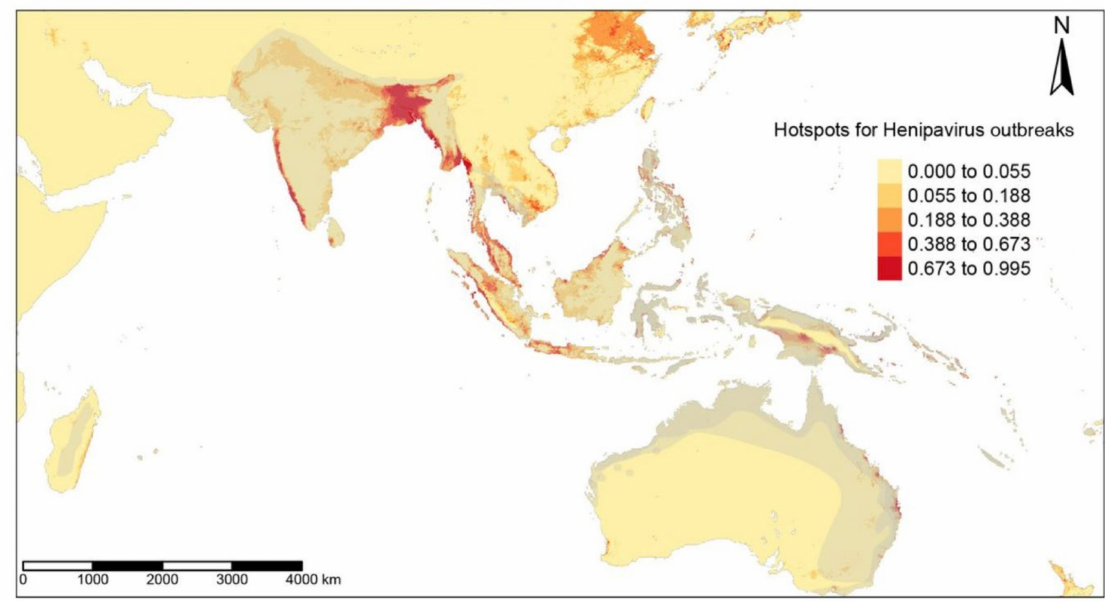
Figure 3. Predictive risks of Henipavirus disease emergence modeled by the ZIB iCAR model with a spatial distribution of the mammalian reservoirs in